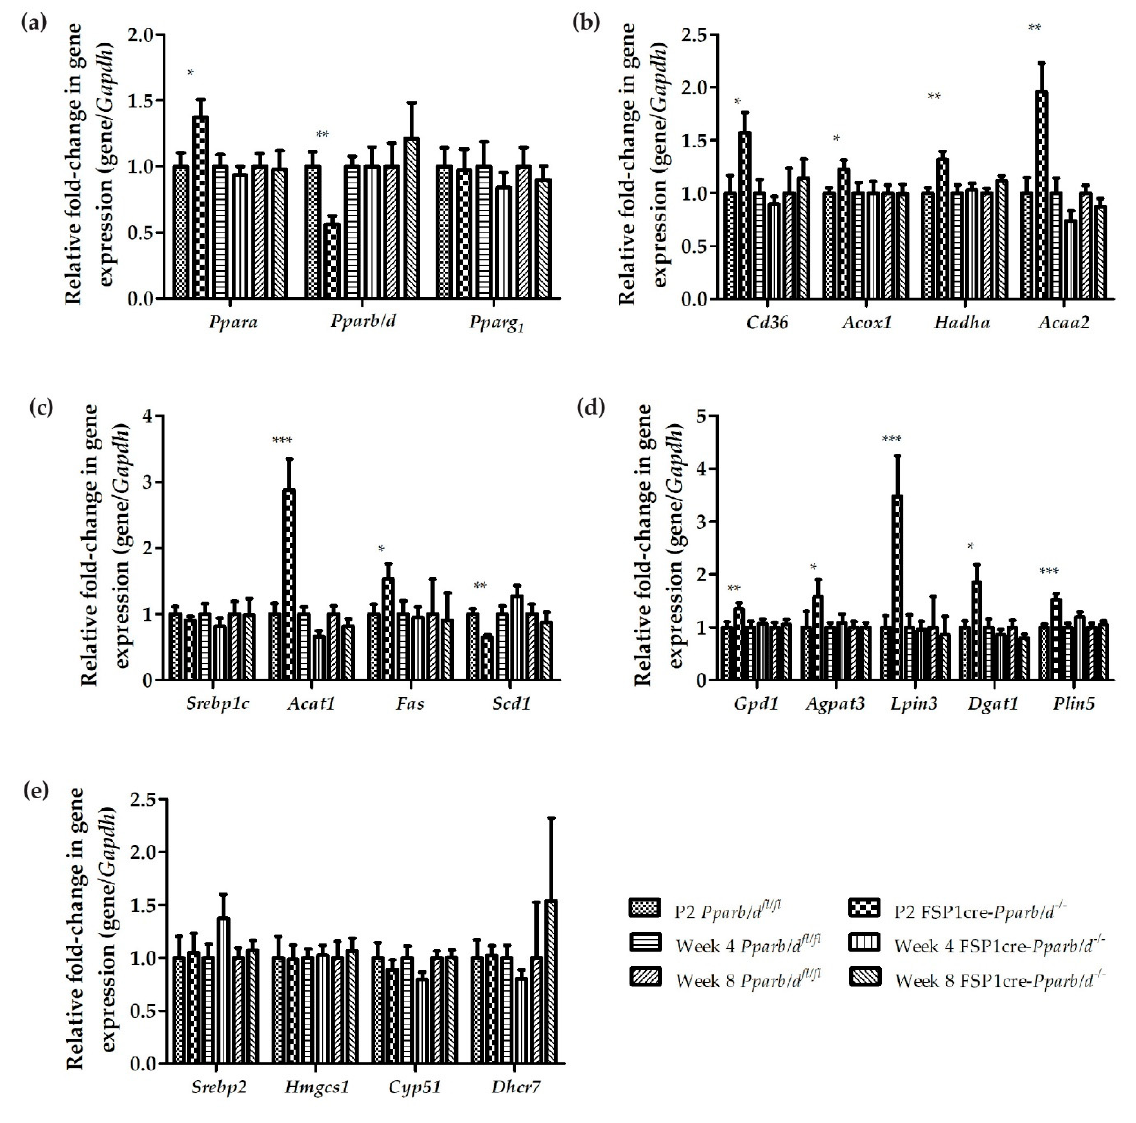
Figure 6. E ff ect of Pparb / d deletion on liver gene expression at P2, week 4, and week 8. Relative fold change in the mRNA levels of specific genes in livers of Pparb / d fl / fl and FSP1cre- Pparb / d − / − mice as determined by real-time qPCR. ( a ) Expression of Ppara, Pparb / d, and Pparg . ( b ) Fatty acid β -oxidation genes. ( c ) Fatty acid synthesis genes. ( d ) Triglyceride synthesis genes and Plin5 . ( e ) Cholesterol synthesis genes. Values are normalized to the expression of Gapdh . Normalized values from controls were arbitrarily assigned a value of 1. Two-tailed Mann-Whitney test with values shown as mean ± s.e.m, n = 10 biological replicates per group. * P < 0.05, ** P < 0.01, *** P < 0.001; FSP1cre- Pparb / d − / − vs. Pparb / d fl / fl